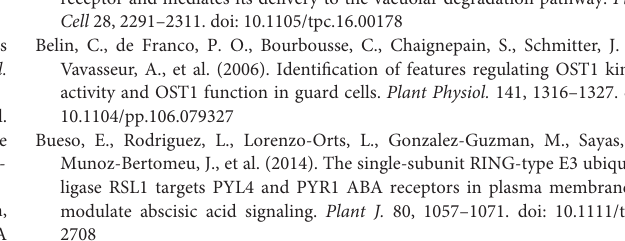
Supplementary Figure 1 | Subcellular localization of PYR1 and PYL4. Localization of PYR1 in the transgenic plants expressing PYR1-GFP . Two independent images from different leaves were shown. Supplementary Figure 2 | BAK1 specifically phosphorylates PYR1. An in vitro kinase assay was performed with each pair of BAK1 and MPK1 (encoded from At1g10210 ), MPK2 (from At1g59580 ) or MPK3 (from At3g45640 ) compared with pair of BAK1 and PYR1. Shorter- and longer-exposed autoradiograms from one representative result after an in vitro kinase assay are shown. Supplementary Figure 3 | Several conserved serine and threonine sites were considered as putative phosphorylation sites of PYR1 by BAK1. (a) Comparison of amino acid sequences of PYR1 and its 13 homologs in Arabidopsis , as analyzed using ClustalW. The seven conserved serine and threonine residues are marked with ∗ . BAK1 phosphorylation sites identified in this study, T137 and S142 of PYR1, are marked with red stars. (b) An in vitro kinase assay was performed to screen for putative phosphorylation sites of PYR1 by BAK1 using mutagenized variants of PYR1. Shorter- and longer-exposed autoradiograms from one representative result after an in vitro kinase assay are shown. Asterisks indicate radioactive signals from unincorporated free radioisotopes. Supplementary Figure 4 | BAK1 interacts with and phosphorylates PYL4. (a) Interaction between BAK1 and PYL4 was detected in protoplasts transfected with HA-BAK1 and HA-PYL4, and ABA increased these interactions. Using anti-BAK1 antibodies, BAK1 was immunoprecipitated from the protein extracts of the protoplasts treated with 30 µ M ABA. Co-immunoprecipitates were identified using anti-HA antibodies. (b) BAK1 phosphorylates PYL4 in vitro . An in vitro kinase assay was performed using either the HIS-tagged BAK1 kinase domain (BAK1) or the kinase-dead form of BAK1 (mBAK1), and HIS-tagged PYL4 (PYL4). Supplementary Figure 5 | BAK1-mediated phosphorylation of PYR1 increases leaf temperature. (a) Overexpression of PYR1 variants did not alter overall growth. Two distinct lines of transgenic plants overexpressing PYR1 , PYR1AA , or PYR1DD were grown for 3 weeks, and their phenotypes were compared with those of the wild-type. The scale bar indicates 10 mm. (b) qRT-PCR analysis was performed to confirm the overexpression of PYR1 genes in transgenic plants and PYR1 levels compared with those in wild-type plants. RNAs were purified from each #1 plant shown in (a) . Data were normalized to the expression levels of UBQ5 . The experiments were repeated thrice. Error bars indicate standard errors. Supplementary Figure 6 | PYR1 , PYR1DD , and PYR1AA were expressed in yeast. (a) Each pair of constructs were transformed successfully. Yeast DNAs were isolated from the transformants that were grown on the media lacking leucine and tryptophan Then the PYR1 gene was amplified by using the sequence in the vector as a forward primer and the sequence in PYR1 as a reverse primer. Yeast actin gene ( ACT1 ) was used for control of PCR. (b) PYR1 , PYR1DD , and PYR1AA were expressed in yeast. Gene expression was examined in yeast RNAs that were isolated from the transformants that were grown on the media lacking leucine and tryptophan. Data were normalized to ACT1 expression levels. Data were analyzed using one-way ANOVA and Tukey’s multiple comparisons test; P < 0.05. Different letters indicate statistically significant